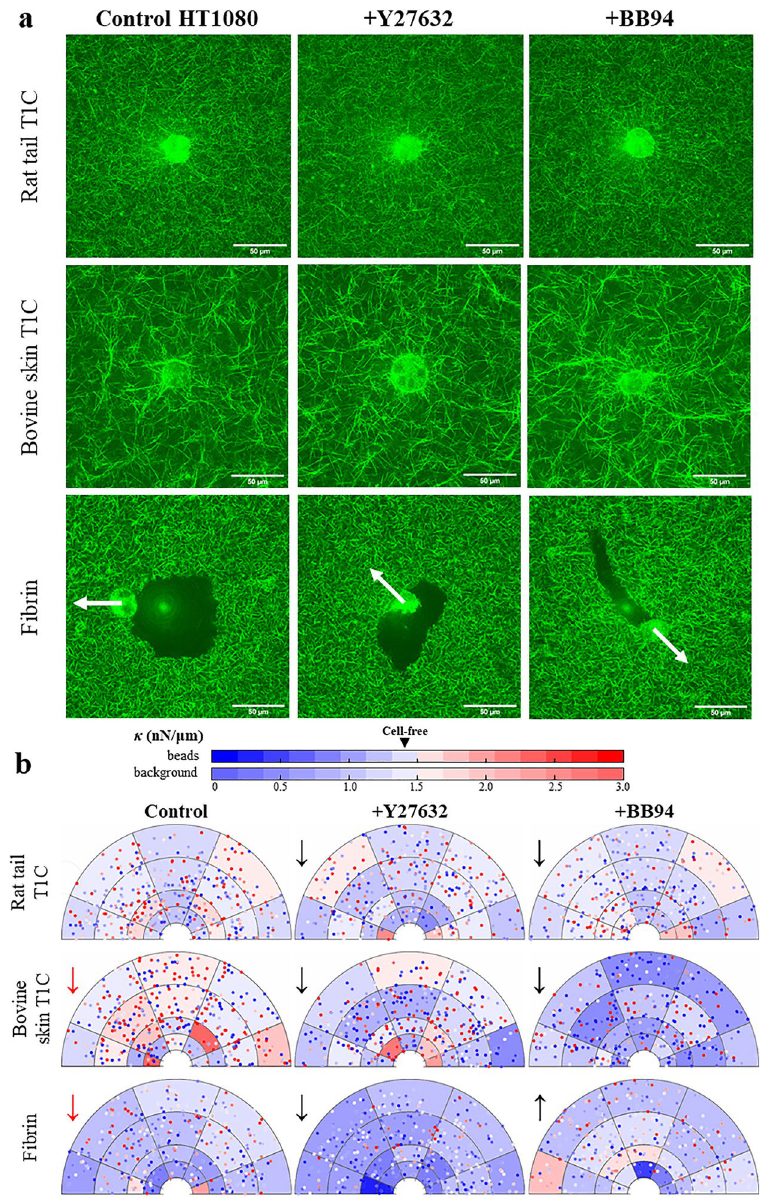
Figure 4. The effect of ECM type and treatment on stiffness distribution around HT1080s. ( a ) RCM images of HT1080 cells cultured in 3 different types of hydrogels (rat tail T1C, bovine skin T1C, fibrin), untreated or treated with Y27632 and BB94 ( n sample = 5, n cells = 10 per condition, n beads > 40 per cell). ( b ) κ distribution around HT1080s, probed along horizontal axis of the image for cells cultured in rat tail or bovine skin T1C. For cells cultured in fibrin hydrogels, κ was probed along the direction closest to the orientation of the enzymatic breakdown, as indicated by the white arrows seen in ( a ). Background color is shaded according to the median κ value in each bin (background color bar). Each data point is a single probed bead, color-coded for κ (beads color bar). Significant difference in κ across tested ECMs (as compared to rat tail T1C, red arrows) or following Y27632 or BB94 treatment (as compared to control condition, black arrows) is marked by arrows indicating increase or decrease in κ. * p <